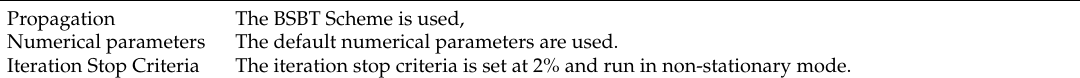
Table 4. Numerical parameters used in the SWAN model